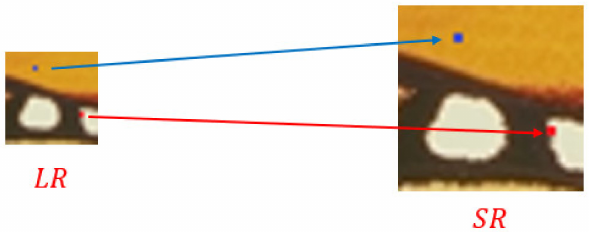
Figure 1. A conceptual illustration of our proposed SR method. Pixels at different positions are upsam- pled using different convolution kernels that match the regularized pattern of the current